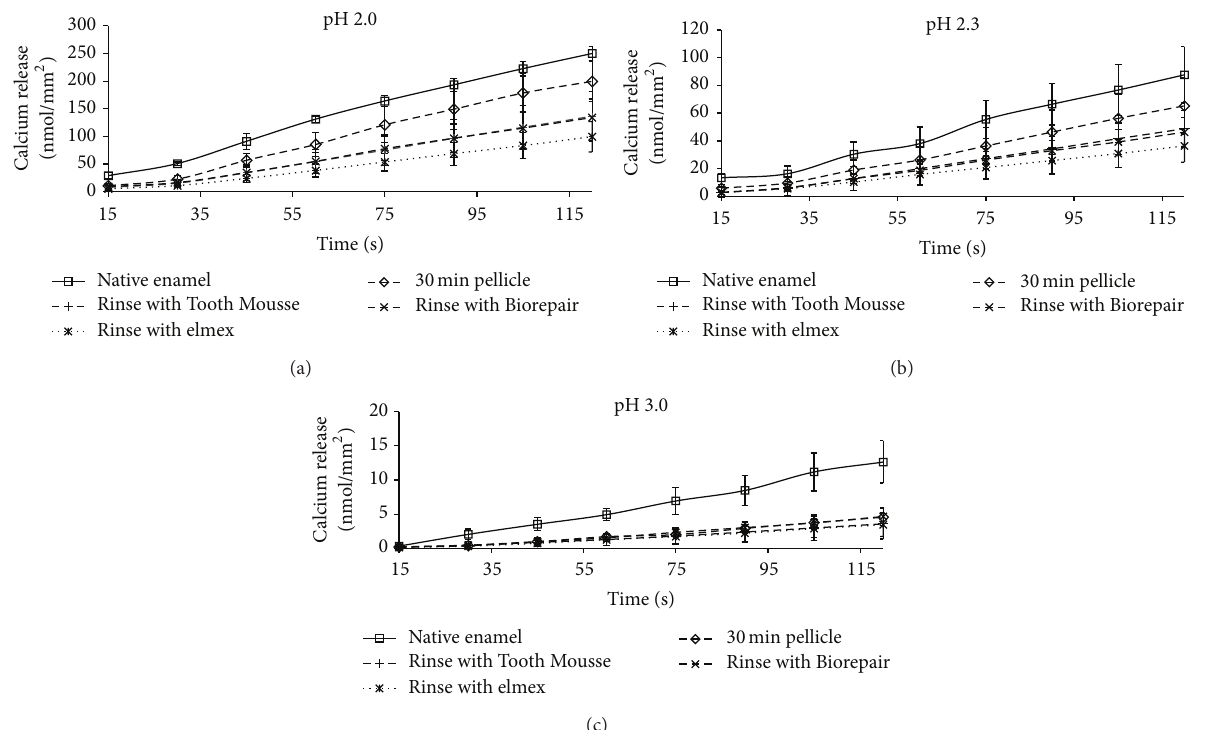
Figure 2: Kinetics of calcium loss during incubation of enamel slabs for 120s with and without application of different preparations in situ . Physiological 30 min pellicles (without rinse) and specimens without pellicle served as controls. In summary the erosion-preventive effect of fluoride was confirmed and could not be achieved by the calcium phosphate and apatite based products. Please note the different scale; 𝑛 = 8 subjects; 𝑛 = 24 enamel samples per subgroup; mean values ± standard